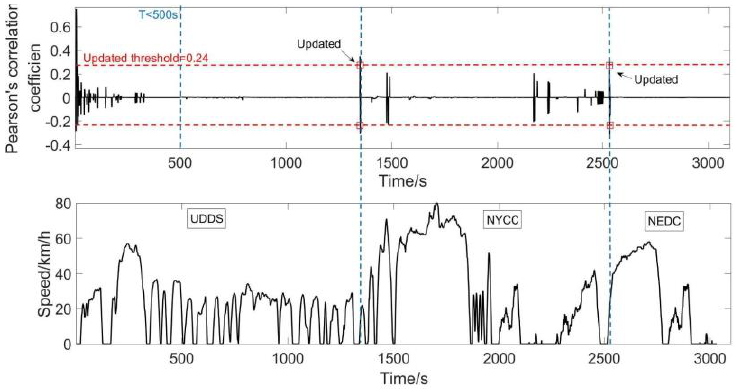
Figure 8. Energy management strategy update time point.